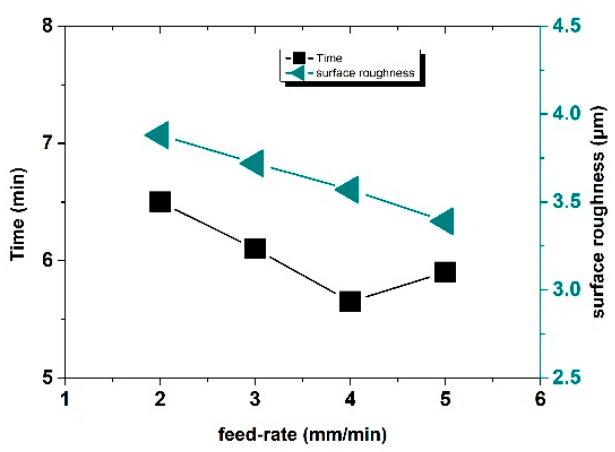
Figure 12. Roughness and machining time of different specimens under different feed rates.